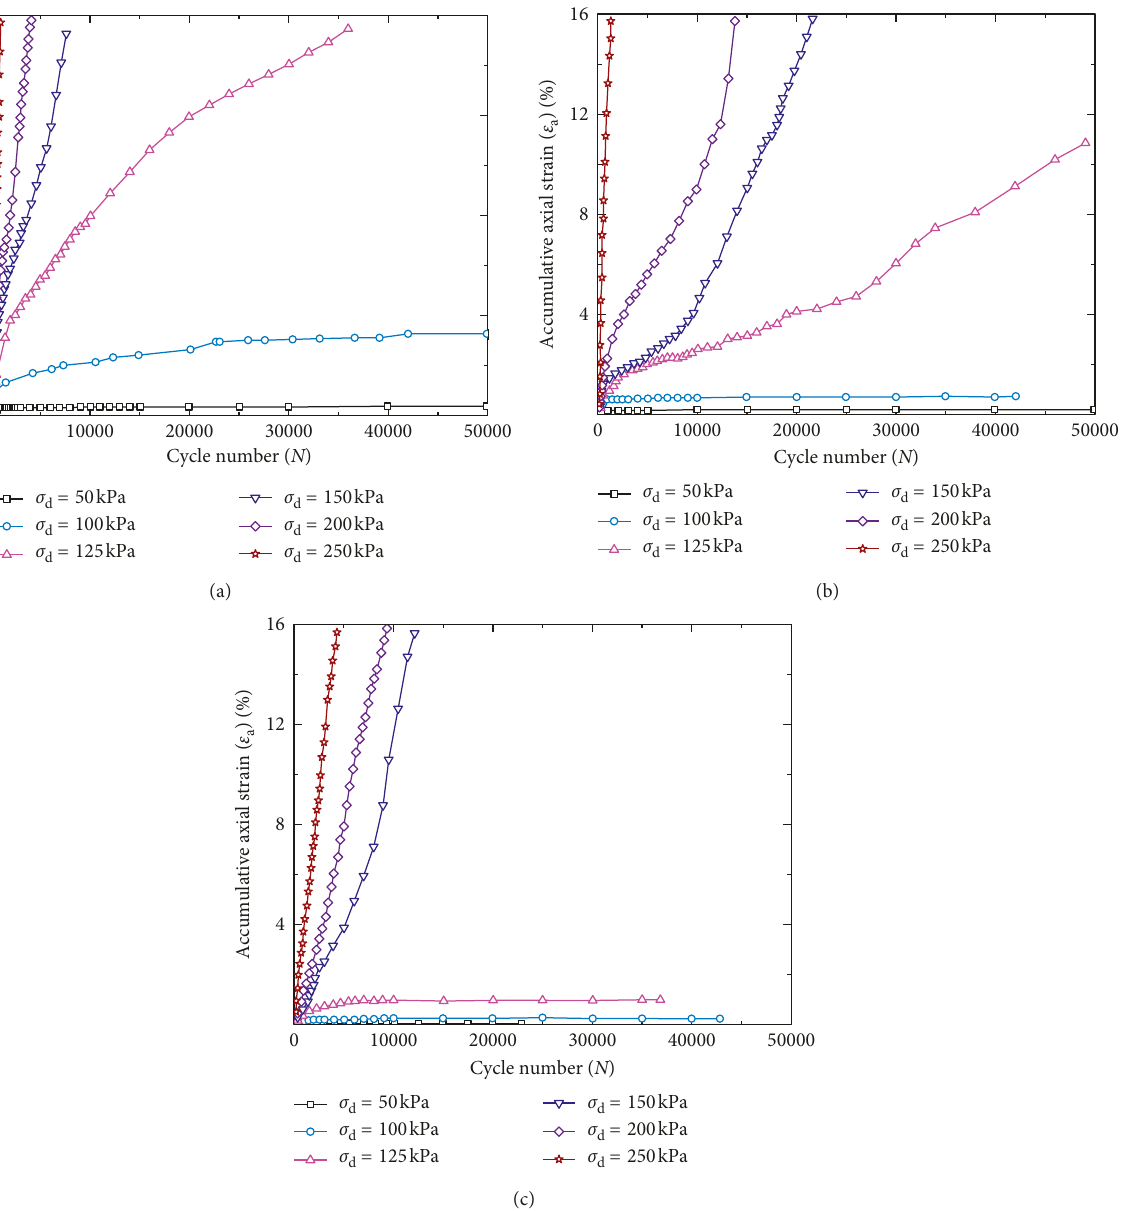
Figure 11: Accumulative axial plastic strain-cycle number curves of tested specimens: (a) σ